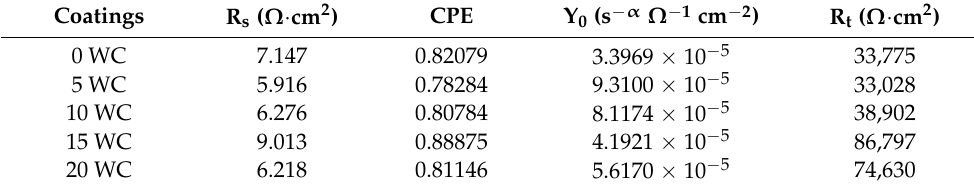
Table 8. AC impedance fitting parameters of different coatings.